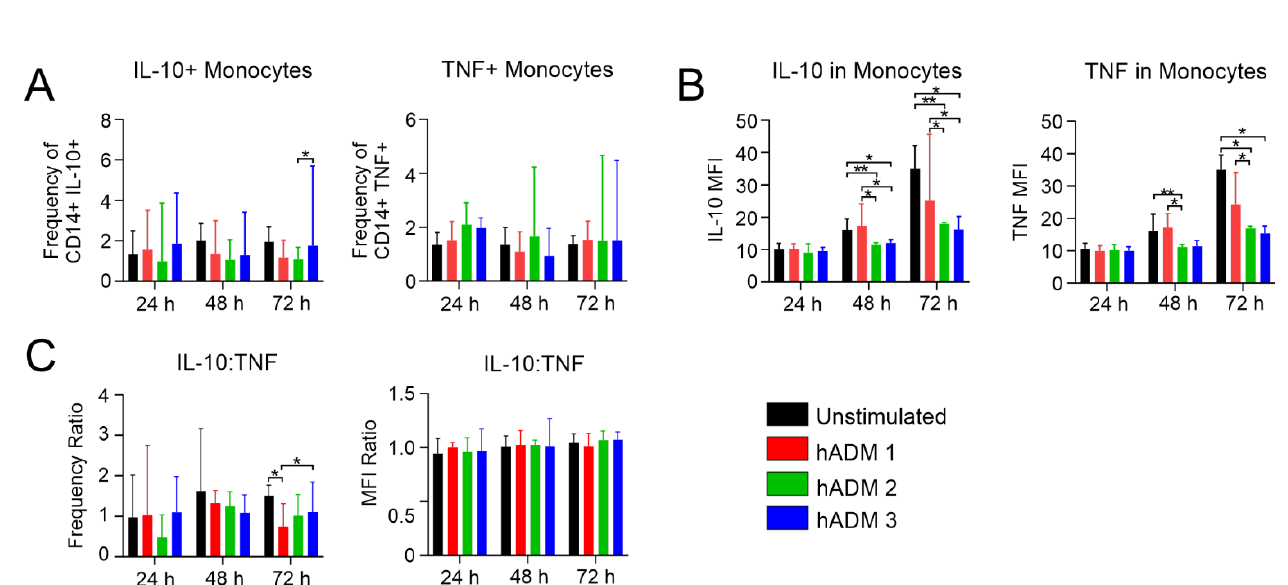
Figure 3. Monocyte effector function is modulated by hADM coincubation. Healthy donor PBMCs were co-incubated alone or with hADMs for 1, 2, or 3 days. A total of 2 h before collection, protein transportation was inhibited. Finally, cells were permeabilized and stained extracellularly and intracellularly before being examined by flow cytometry. ( A ) Frequency of CD14+/IL-10+ or TNF+ monocytes. ( B ) MFI quantification of CD14+/IL-10+ or TNF+ monocytes. ( C ) Frequency and MFI ratios of IL-10:TNF. Results expressed as medians + interquartile ranges. Two-tailed Wilcoxon matched-pairs signed-rank test used for ( A – C ) n = 5 with 2 technical replicates; * p = 0.05, ** p = 0.01.